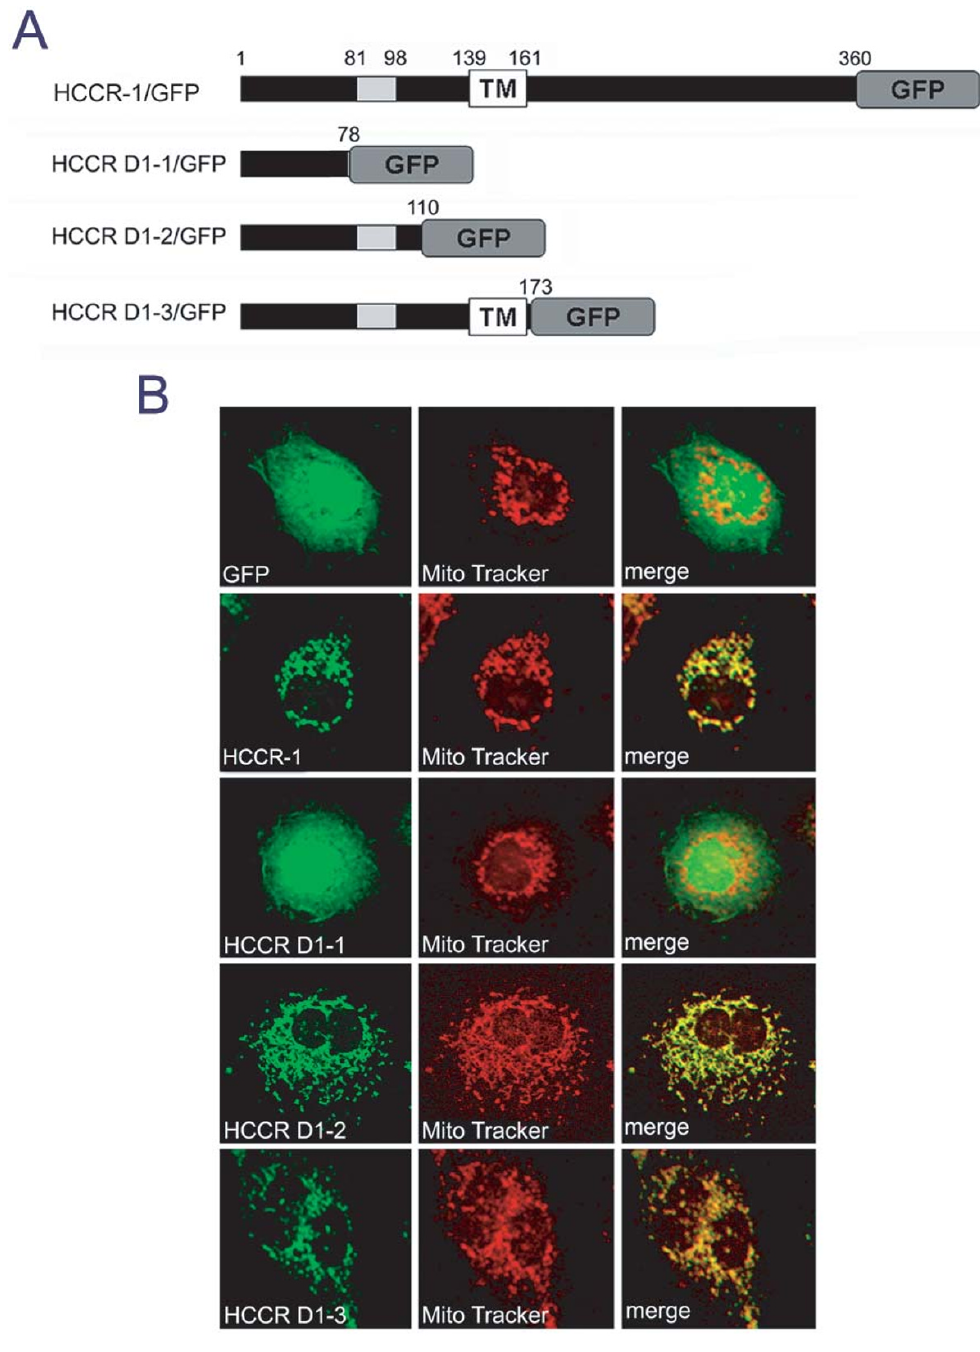
NH -terminus of HCCR-1 contains the mitochondrial targeting information Figure 3 2 -terminus of HCCR-1 contains the mitochondrial targeting information . (A) Schematic structure of HCCR-1 NH 2 and its deleted mutants which were COOH-terminally linked by the GFP reporter gene. Grey boxes indicate the hydrophobic region. TM boxes indicate the locations of putative transmembrane domain. (B) Expression of wild-type or deleted mutants in COS-7 cells. COS-7 cells were transfected with the indicated constructs in the expression vectors. The cells were incubated with MitoTracker and fixed. Fluorescent images of GFP (green), MitoTracker (red) were taken using a confocal microscope. Merged fluorescent images of GFP and MitoTracker are shown. Other conditions are described in Materials and